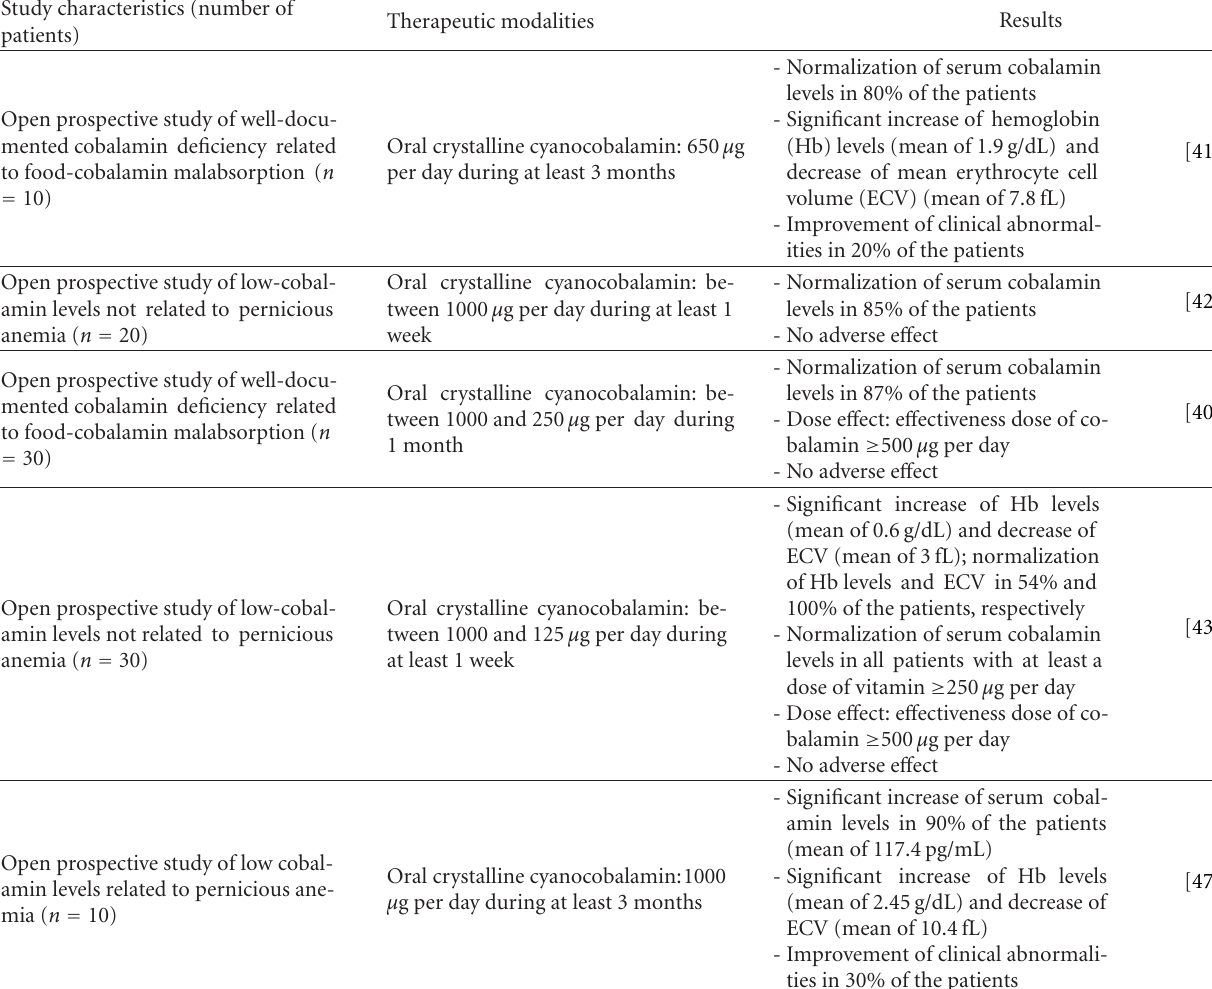
Study characteristics (number